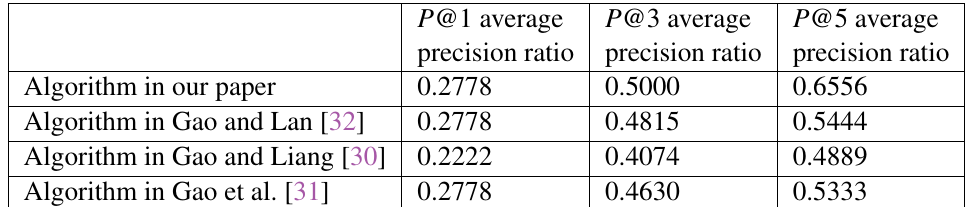
Table 4. The experiment results of ontology